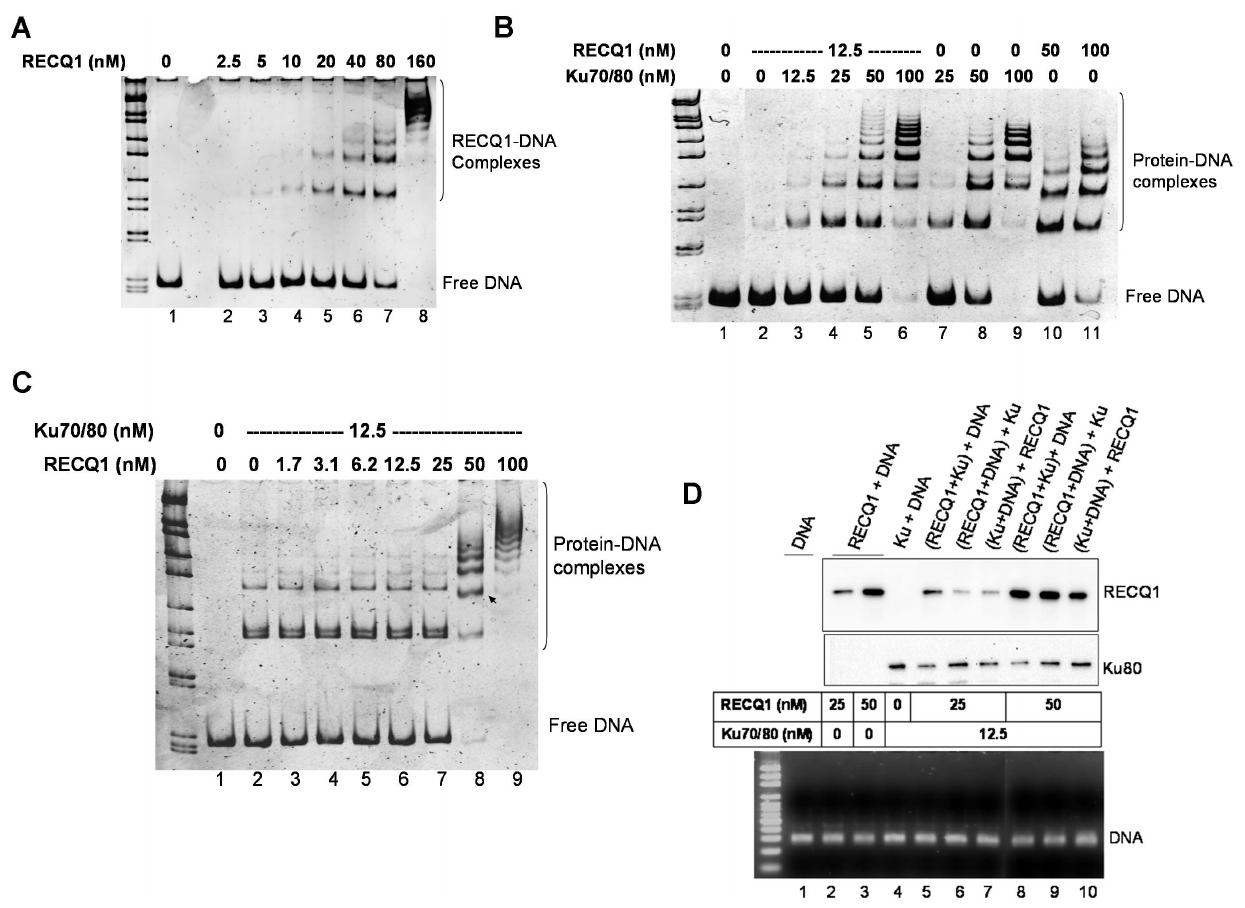
Figure 4. RECQ1 and Ku70/80 co-bind a linear blunt duplex DNA. A. RECQ1 binds a 322 bp blunt duplex fragment derived from pUC19 plasmid DNA. An electrophoretic mobility shift assay (EMSA) was performed to examine the ability of increasing concentration of purified RECQ1 to bind linearized plasmid DNA (30 ng) under DNA binding conditions as described in materials and methods. Protein-DNA complexes were resolved by native 6% polyacrylamide gels and detected by staining with SYBR Gold and a typical inverted image is shown. B. RECQ1 facilitates the formation of higher order DNA complex with Ku70/80. EMSA was performed to examine the ability of increasing concentration of Ku70/80 (0–100 nM) to interact with RECQ1 (12.5 nM) when bound to linear plasmid DNA (30 ng). Both RECQ1 and Ku70/80 bind to blunt duplex resulting in a series of progressively retarded bands, but the mobility of RECQ1-DNA and Ku70/80-DNA complex is distinct. Additional slow migrating bands were observed in Ku70/80 (25, 50 and 100 nM) in the presence of RECQ1 (12.5 nM) (lanes 4–6 and 7–9). C. Molar excess of RECQ1 may compete with Ku70/80 for DNA binding. EMSA was performed to examine the ability of increasing concentration of RECQ1 (0–100 nM) to interact with Ku70/80 (12.5 nM) when bound to linearized plasmid DNA (30 ng) (lane 7 and 8). Arrow indicates the change in band shift pattern of DNA-protein complexes at 50 nM RECQ1. D. RECQ1 and Ku70/80 are co-bound to linear blunt duplex. EMSA reactions were performed using biotinylated DNA probe and the indicated concentration of RECQ1, Ku70/80 or both. The DNA probe was either exposed to a mixture of RECQ1 and Ku70/80, or pre-incubated with one protein followed by addition of the second protein as indicated by parentheses. The DNA-protein complexes were pulled-down on streptavidin magnetic beads and DNA-bound RECQ1 and Ku70/80 were analyzed by Western blotting. Comparable amount of DNA was pull-down in all reactions as shown by agarose gel analyses (bottom). Lane 1 represents biotinylated DNA bound to the streptavidin beads in the absence of RECQ1 or Ku70/80. DNA size marker is shown in leftmost lane of each